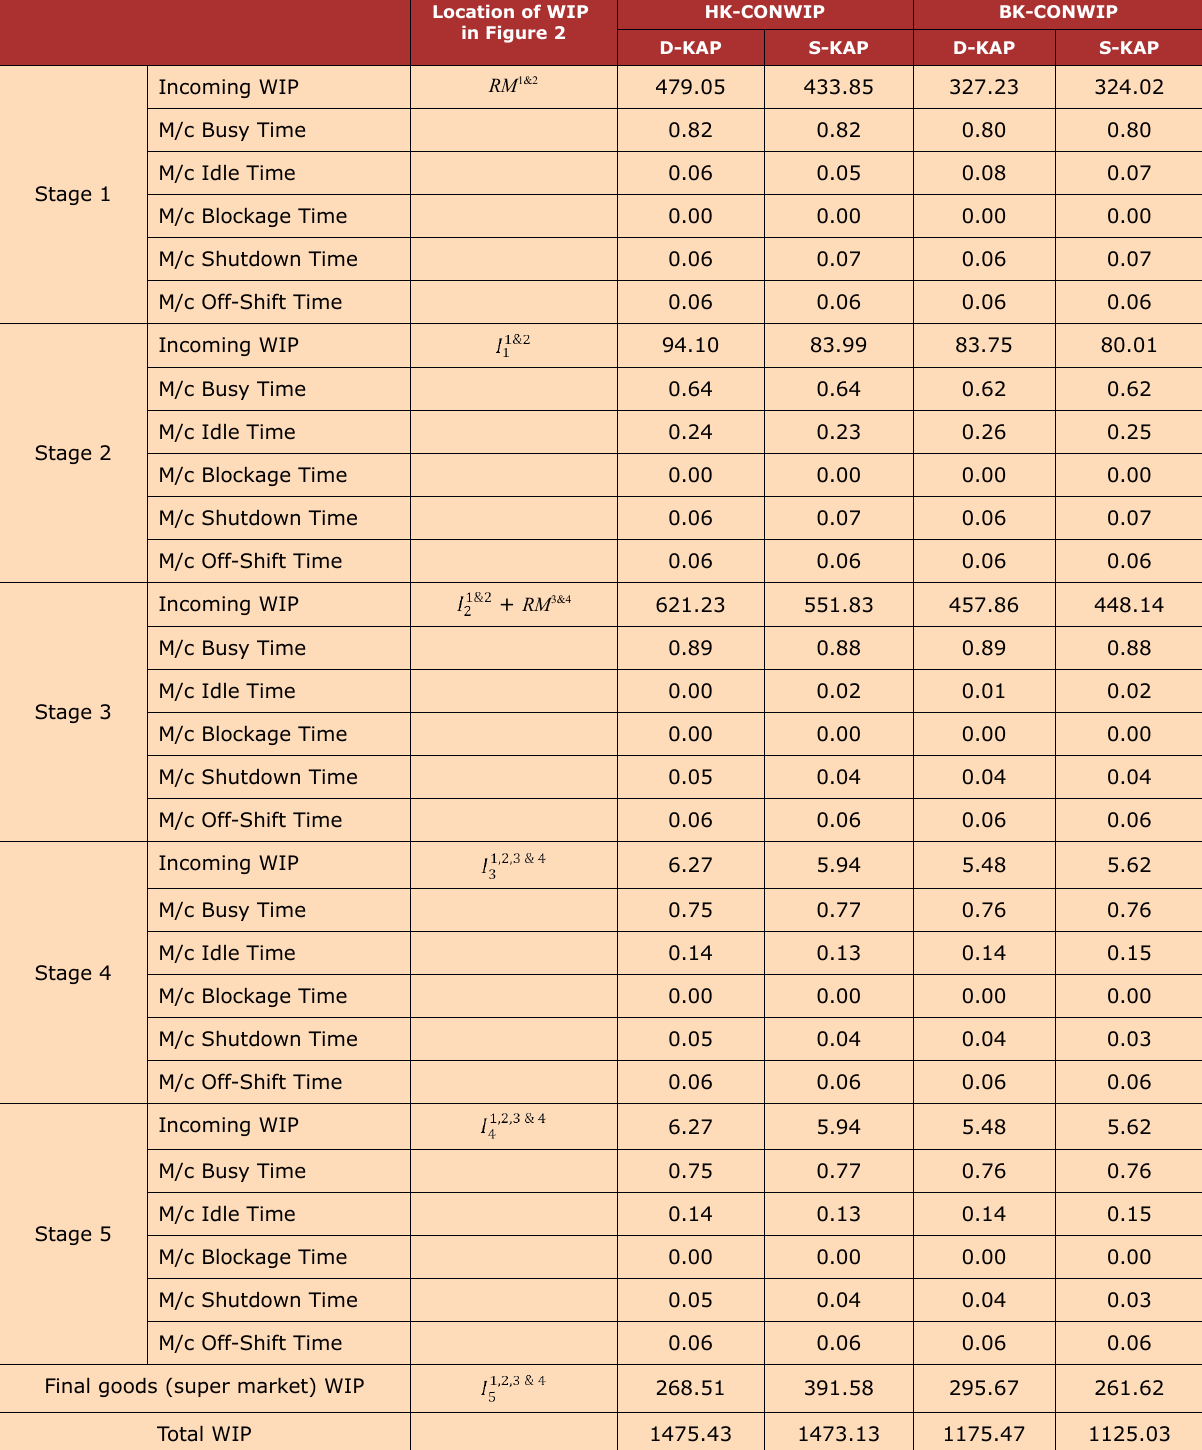
Table 14. Case 2 stage state statistics of PCS+KAP at targeted 100% service